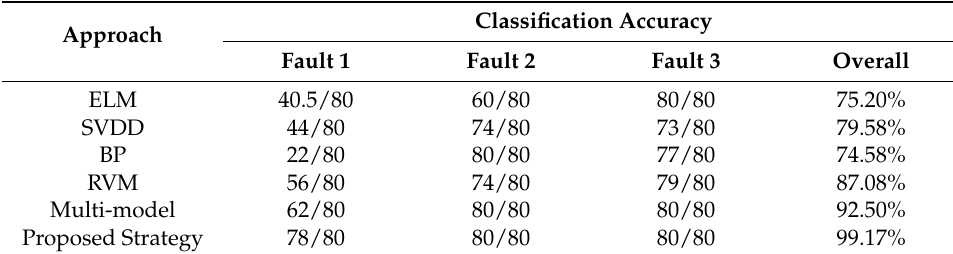
Table 3. Comparison of classification results.